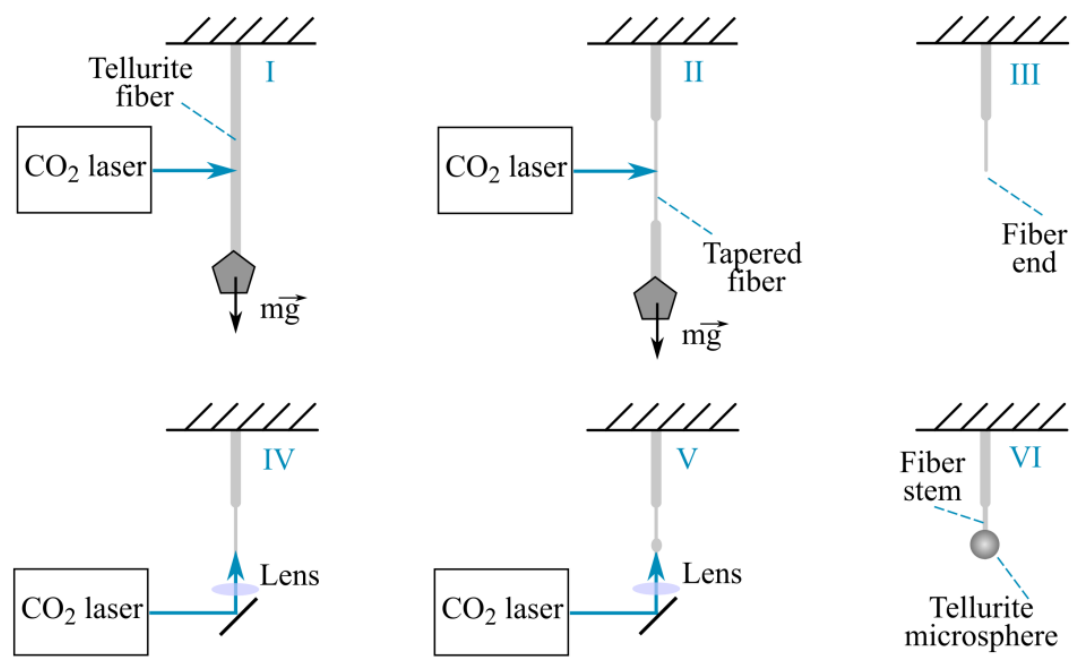
Figure 2. Schematic representation of the successive stages of fabrication of microresonators from single-index tellurite fiber.